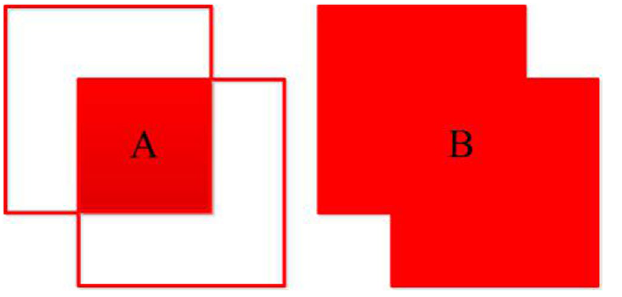
Figure 4. The IoU between two detection boxes. Here, ( A ) denotes the area of overlap between the two boxes, while ( B ) is the area of union of the two boxes. Therefore, the IoU is the ratio of ( A to B